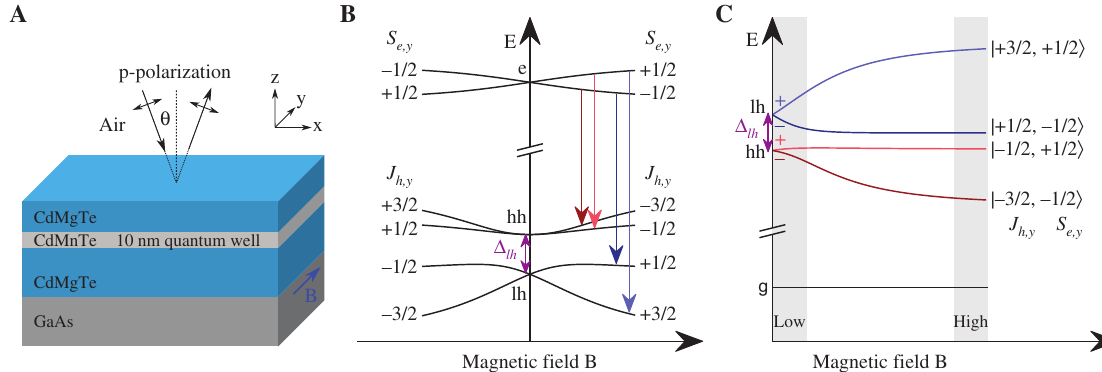
Figure 3: (A) Schematic presentation of the studied DMS QW structure and geometry of the experiment under light incidence. Magnetization M and external magnetic field B are oriented in the QW plane. (B) Energy diagram and Zeeman splitting of conduction and valence band states in Voigt geometry (single particle picture). Vertical lines indicate the relevant dipole-allowed optical transitions with elliptical polarization in xz -plane (optical transitions with linear polarization along magnetic field direction are not considered here). Red/blue lines correspond to σ + / σ − polarization in the xz -plane in the limit of large magnetic fields where the electron and hole eigenstates are defined by the angular momentum projections on magnetic field direction S and J , respectively. At B = 0, the hh and lh states are split e , y h , y by Δ . (C) Energy diagram from (B) in the exciton picture. Gray areas indicate the limiting cases of low and high magnetic fields. For low lh magnetic fields, the upper two transitions correspond to the lh exciton ( lh , light and dark blue lines, respectively), whereas the lower + , − ones correspond to the hh exciton ( hh , light and dark red lines, respectively). Due to admixture from the lh to the hh, the states at high + , − magnetic field are denoted as labeled within the figure. The labeling of exciton states in this case is given by the | J , S ⟩ notation. h ,y e , y